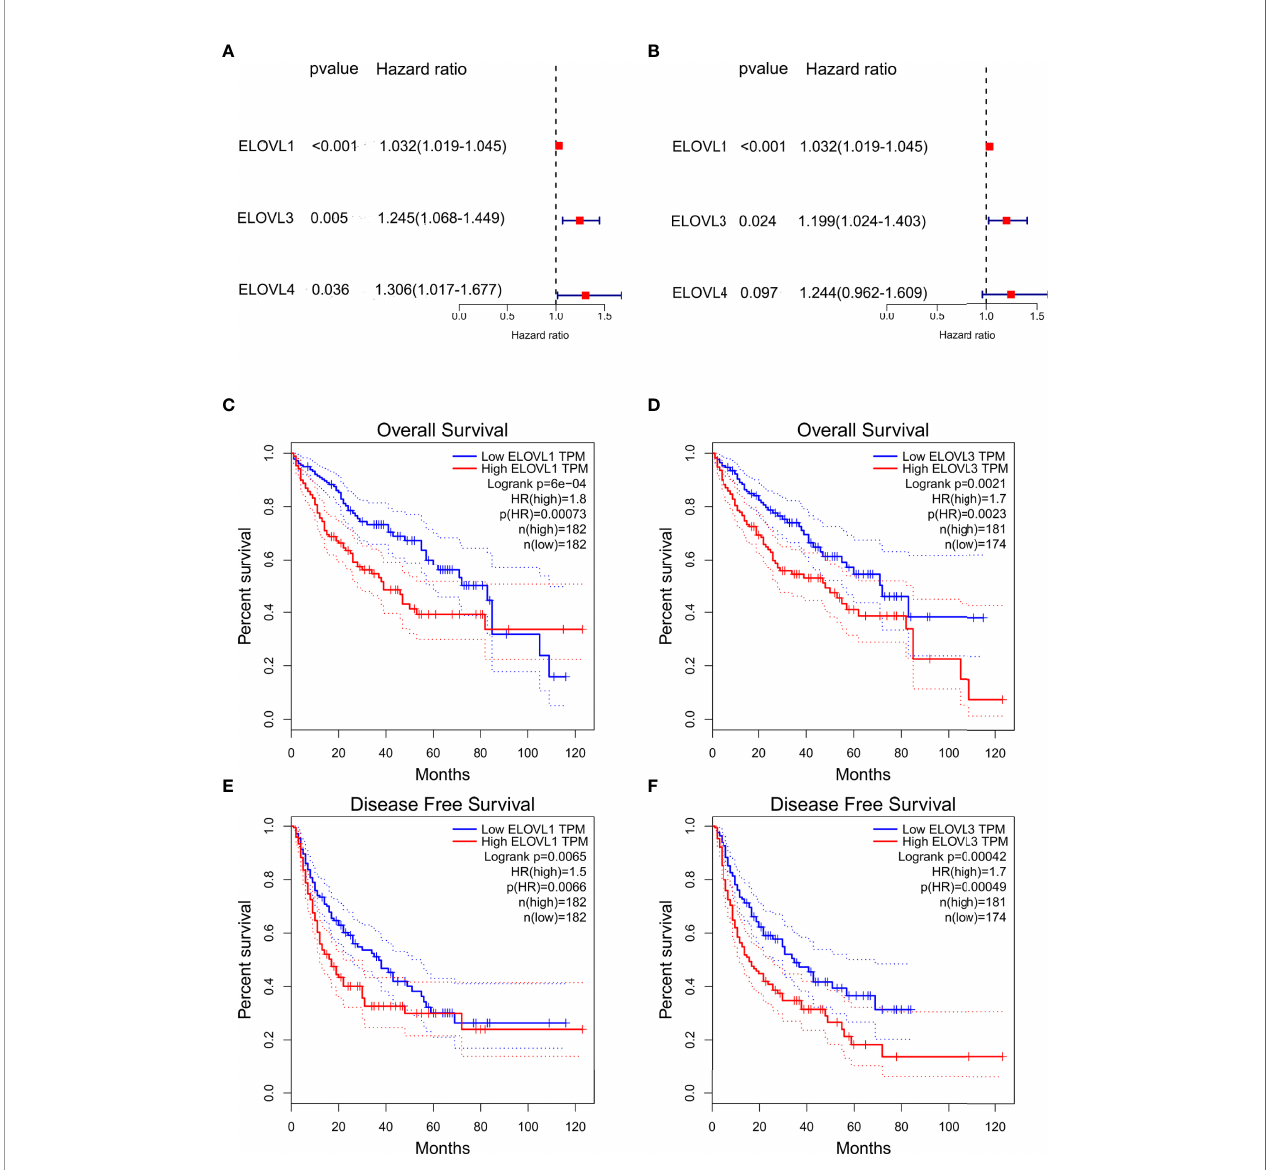
FIGURE 3 | The prognostic value of ELOVLs family in HCC. (A) Univariate Cox regression analysis of ELOVLs in patients with HCC in TCGA database shows ELOVL1, -3, and -4 relating to the prognosis of HCC. (B) Multivariate Cox regression analysis of ELOVLs in patients with HCC in TCGA database shows ELOVL1 and ELOVL3 relating to the prognosis of HCC. (C – F) Overall survival (OS) and disease-free survival (DFS) of low- and high-expression groups of ELOVL1 and ELOVL3 in Kaplan – Meier